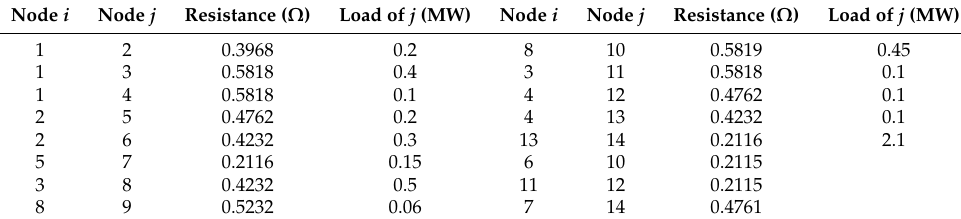
Table 5. Parameters of microgrids 2 and 3.